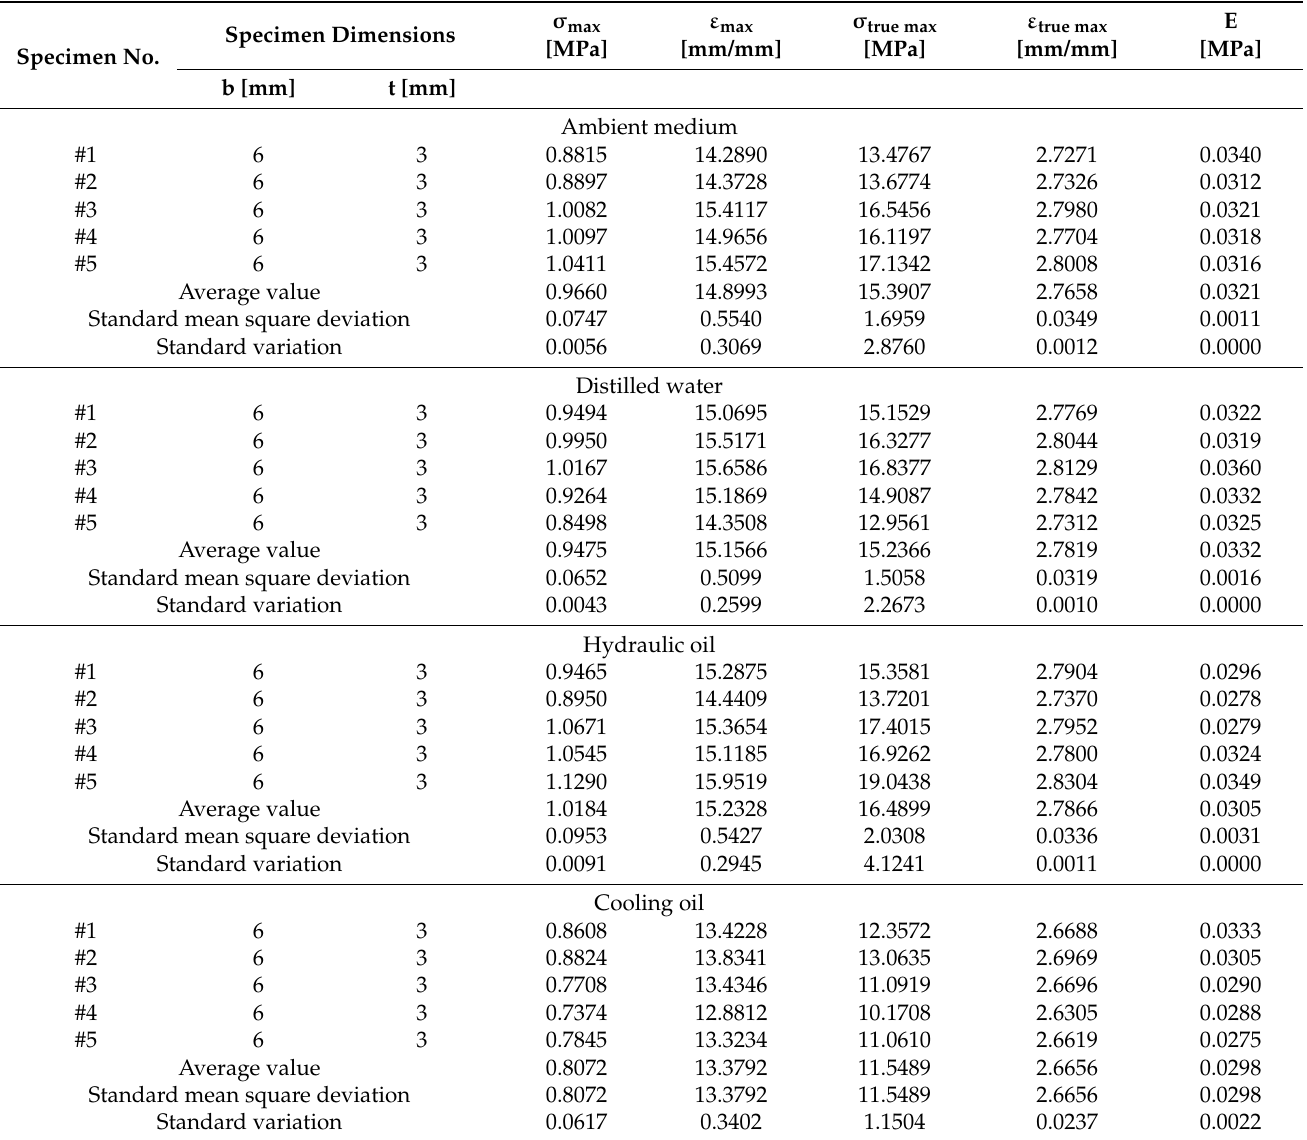
Table 1. Dimensions of 00-30 specimens, maximum tensile stress, maximum tensile strain, maximum true stress, maximum true strain, and maximum tensile